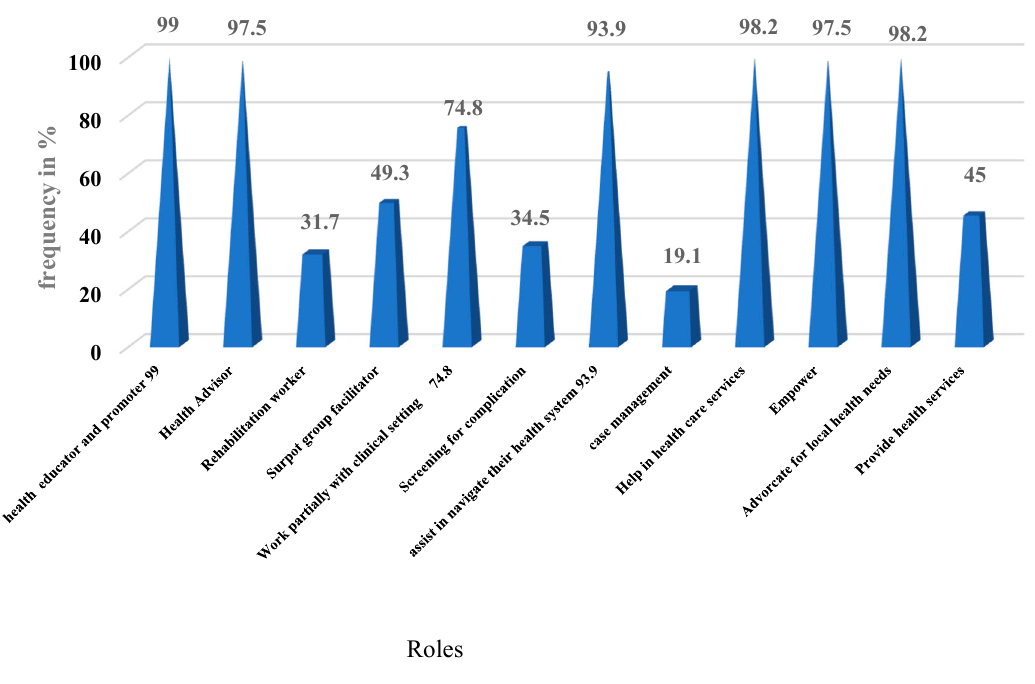
Figure 1. Role of community health workers.